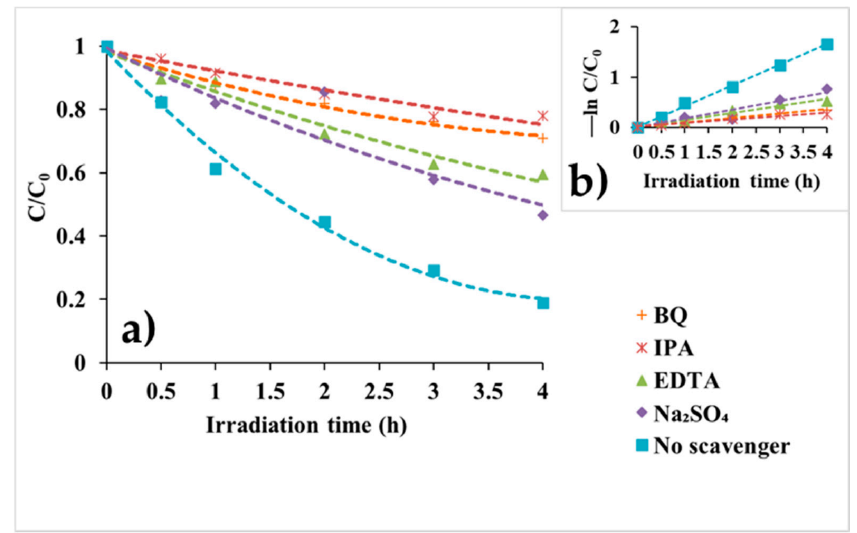
Figure 10. ( a ) Effects of chemical scavengers on TiO 2 /ZnO/CuPc photocatalyst degradation efficiency of IBF (C 0 = 5 mg/L, pH 6.50), and ( b ) corresponding degradation rate constant.